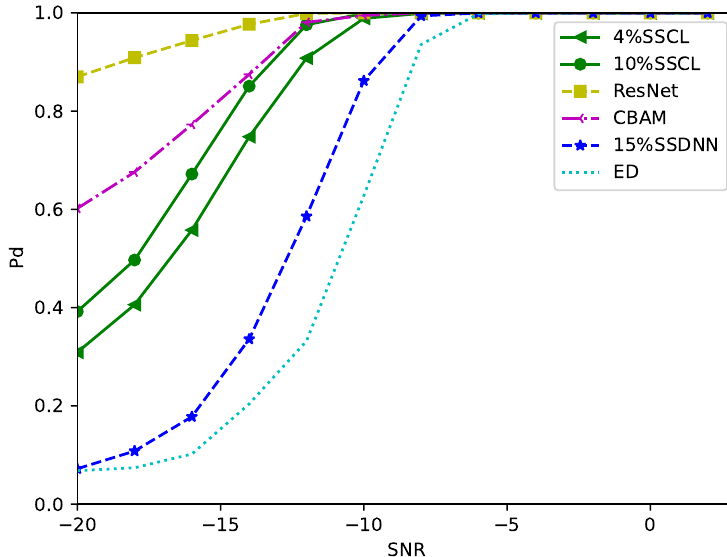
Figure 10. Comparison of detection performance of different